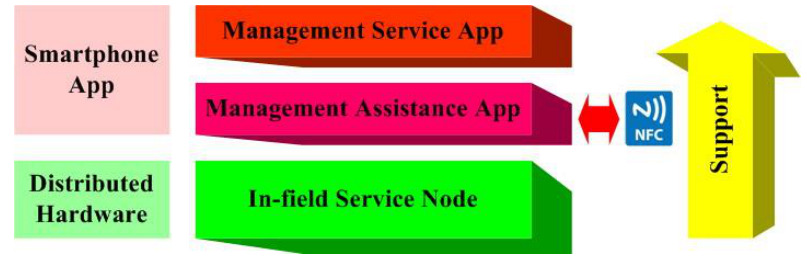
Figure 1. Function schematic of presented system.